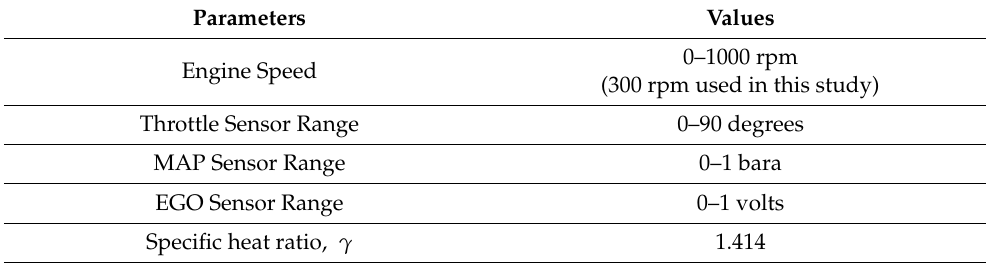
Figure 7. Flowchart for proposed HFTCS. Table 1. Model Parameters